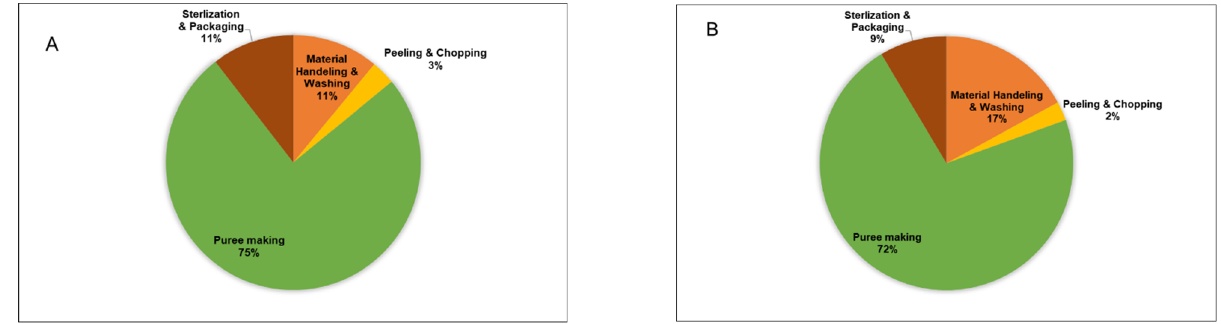
Figure 2. Equipment cost breakdown among various sections of the plant: ( A ) base case, ( B ) case 2.